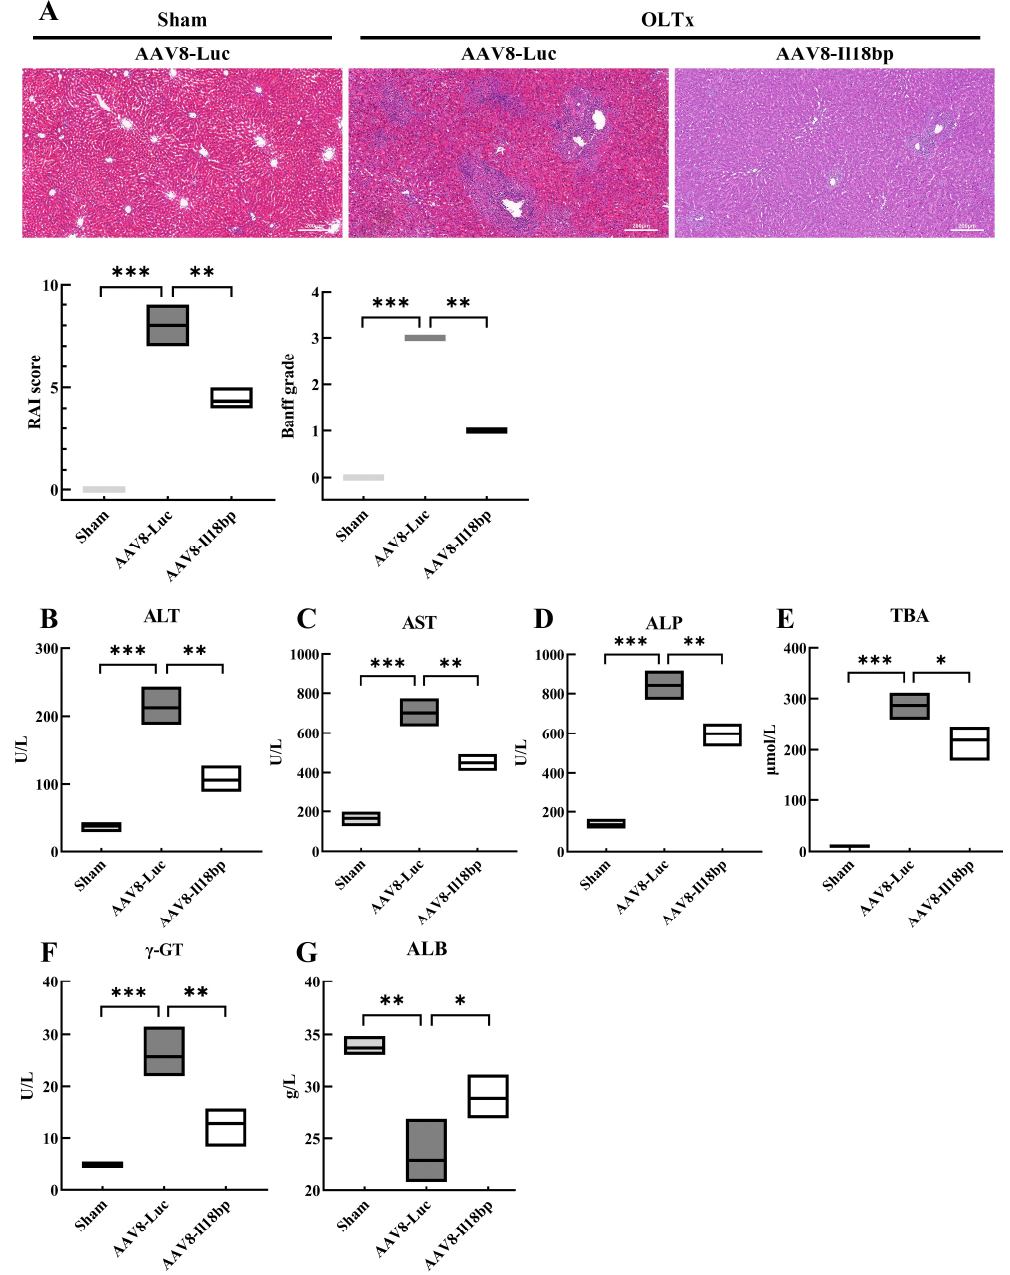
Figure 4. Increased IL-18BP levels protected liver function from immune rejection after LEW-BN OLTx. ( A ) Histopathological changes in the liver after LEW-BN OLTx were shown by HE staining. Liver histopathologic analysis RAI score for Banff criteria (sham group: 0 points; AAV8-Luc group: 7–9 points; AAV8-Il18bp group: 3–5 points). Banff grade for Banff criteria (sham group: grade 0; AAV8-Luc group: grade III; AAV8-Il18bp group: grade I). Scale bar = 200 µ m. ( B – F ) After